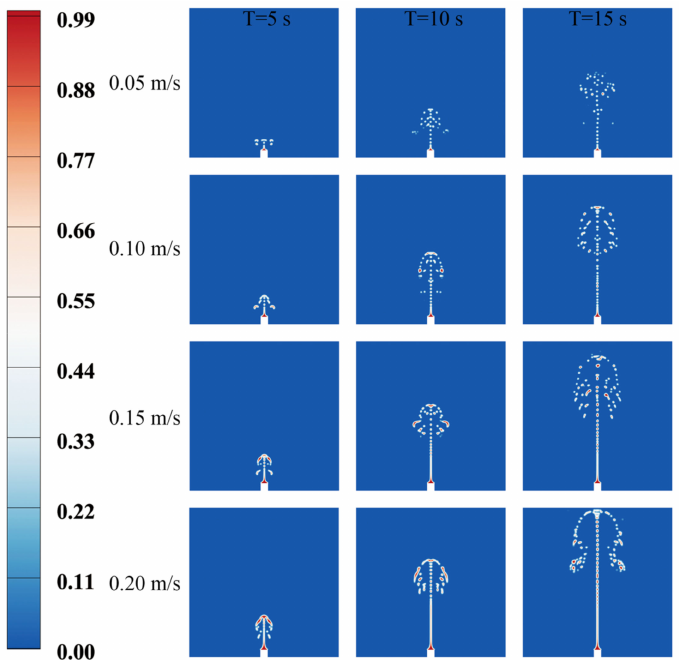
Figure 4. Analysis of influence of spill velocity on oil spill leakage and diffusion ( U 0 = 0